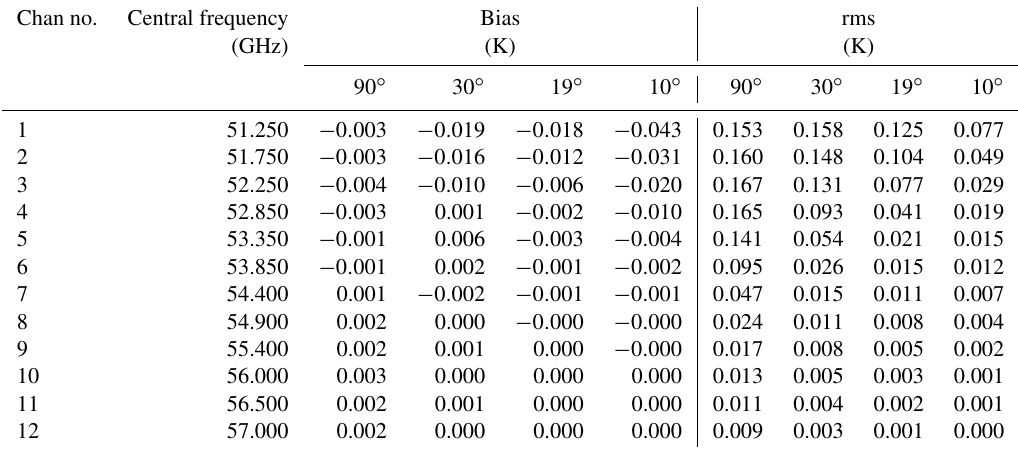
Table 3. Statistics for the comparison between RTTOV-gb and the line-by-line model R98 (Rosenkranz, 1998) used for training against an independent profile set. The TEMPERA instrument channel number (Chan no.), the channel central frequency, bias, and rms at four elevation angles are reported.